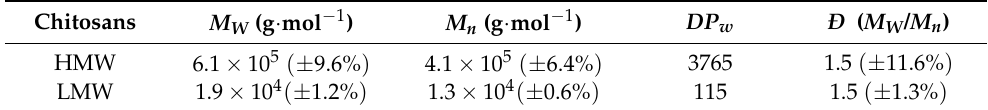
Table 1. Weight-average ( M W ) and number-average ( M n ) molar masses, polymerization degree DP , and dispersity Ð of the starting high molar mass HMW, and the low molar mass chitosan LMW obtained after depolymerization by nitrous